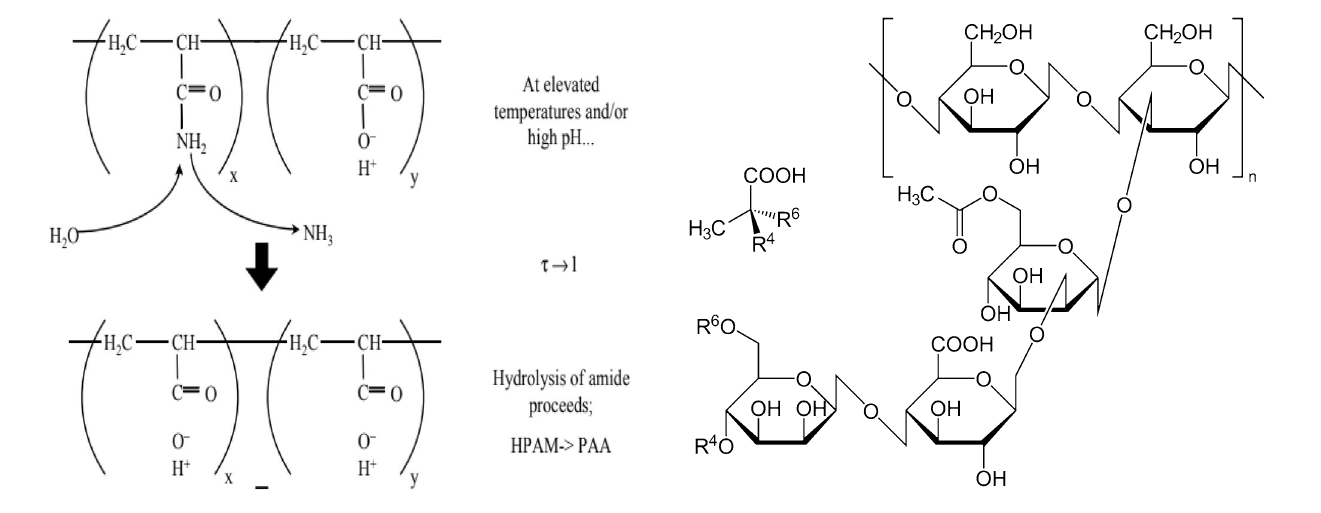
Fig. 1 Hydrolysis of PAM